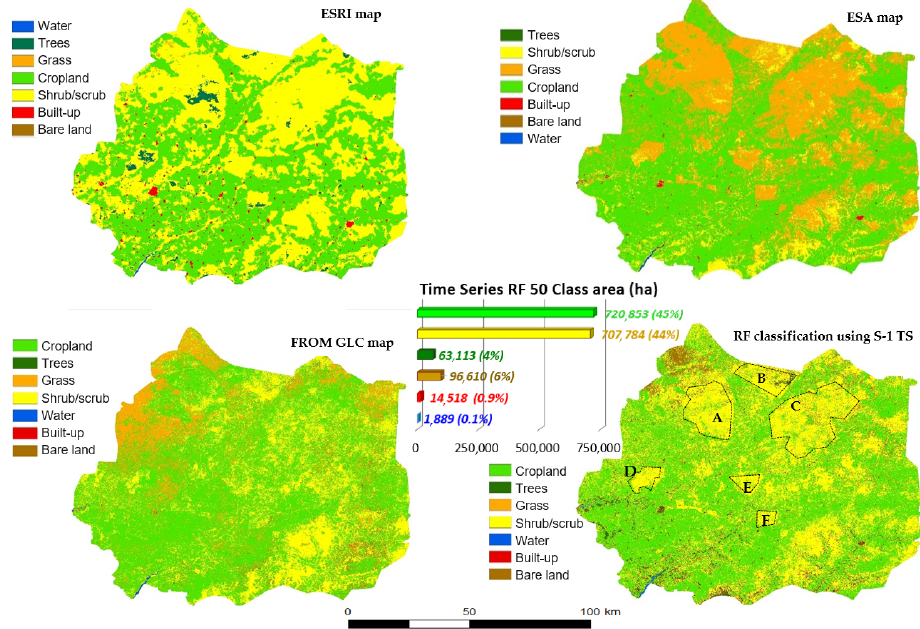
Figure 9. Comparison between our land cover map of Kaffrine obtained from RF50 and other available land-use products; ESRI, ESA, and FROM-GLC land cover maps. A: Mbégué Sylvo Pastoral Reserve, B: Doli Sylvo Pastoral Reserve, C: Sine-Saloum Sylvo Pastoral Reserve, D: Birkilane Forest, E: Delbi Forest, and F: Malem Hodar